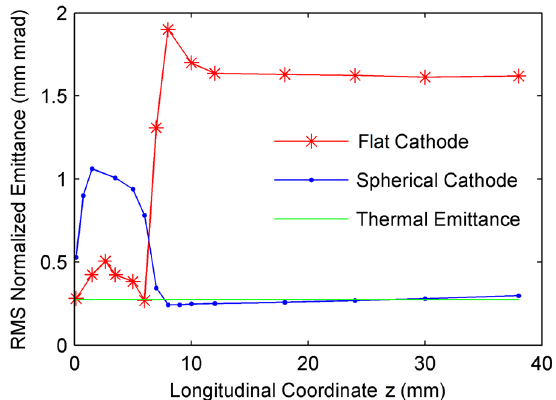
ffiffiffiffiffiffiffiffiffiffiffiffiffiffiffiffiffiffiffiffiffiffiffiffiffiffiffiffi p ϵ ð z Þ 2 þ Δ ϵ 2 n n in